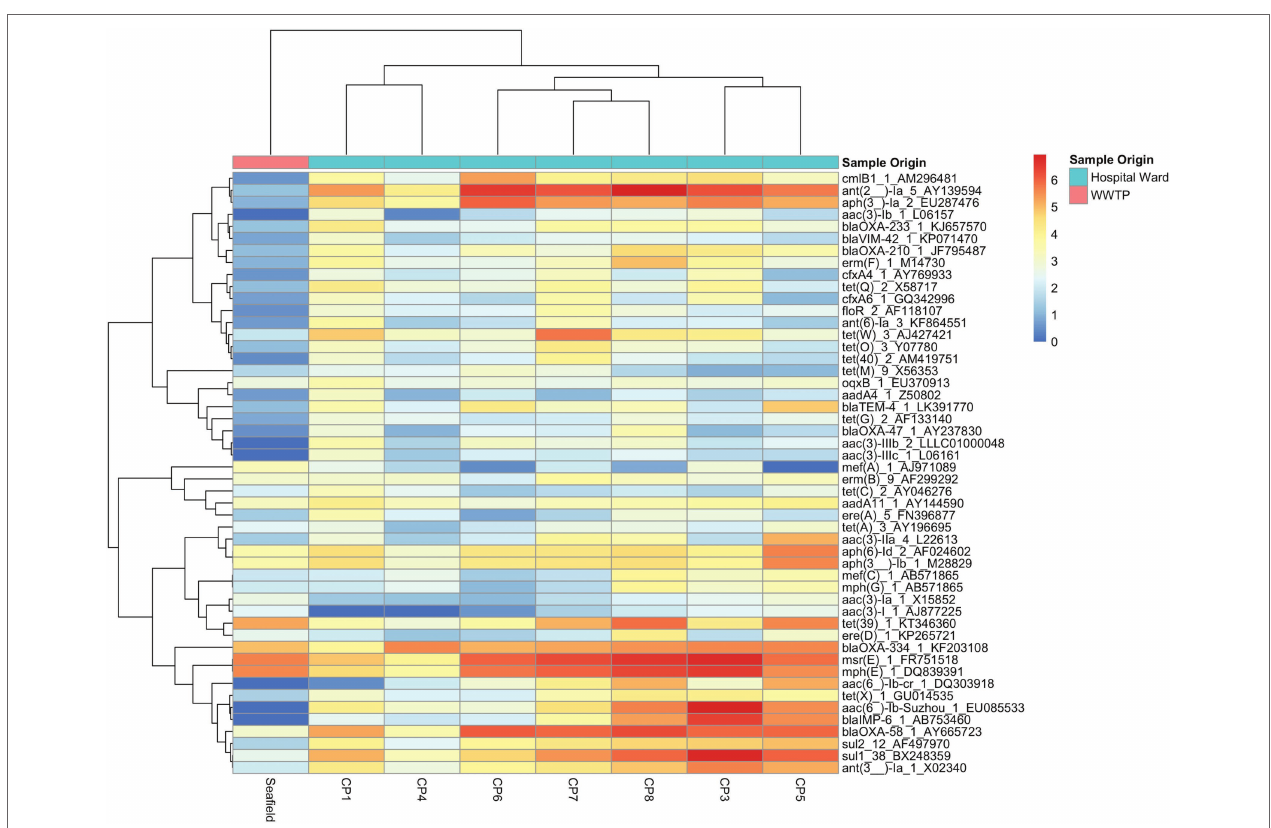
FIGURE 2 | Heat map of 50 most abundant ARGs. Relative abundance of ARGs (RPKM) were log transformed and both ARGs and CPs were clustered using complete-linkage clustering. For ARGs clustering was based on Pearson correlation coefficients, for collection points clustering was based on the BC-dissimilarity matrix ( Figure 1 ) which uses all